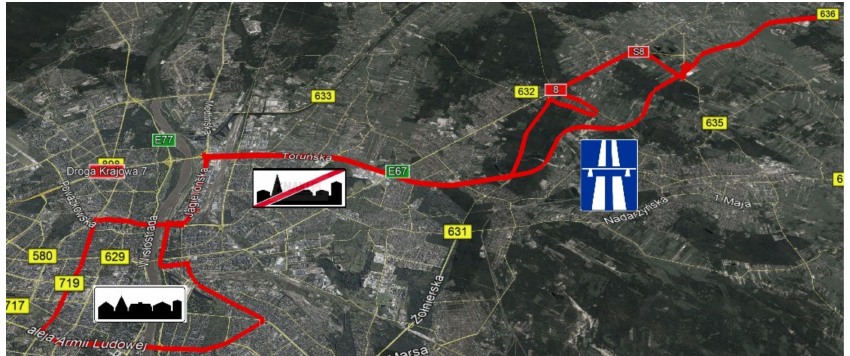
Figure 1. RDE trip route for tests of passenger